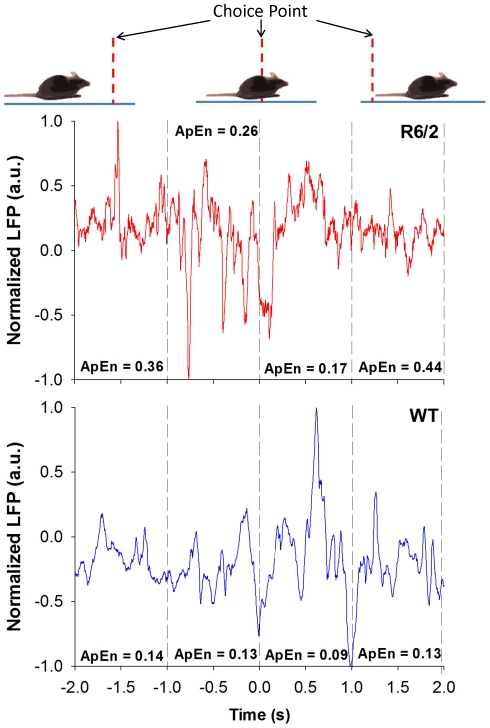
Exemplar LFP dynamics around the choice point.These are data obtained from a single, choice-point crossing during a trial for a single animal within each group. Both choices represent the animal crossing the choice point and remaining in the same arm. The ApEn values within the time windows of A) 2 s to 1 s prior; B) 1 s to 0 s prior; C) 0 s to 1 s after; and D) 1 s to 2 s after crossing the choice point are also illustrated. Note that the data have been normalized to fall between −1 and 1, so as to highlight the differences in dynamics (hence, the scale on the y-axis is in arbitrary units, a.u.).